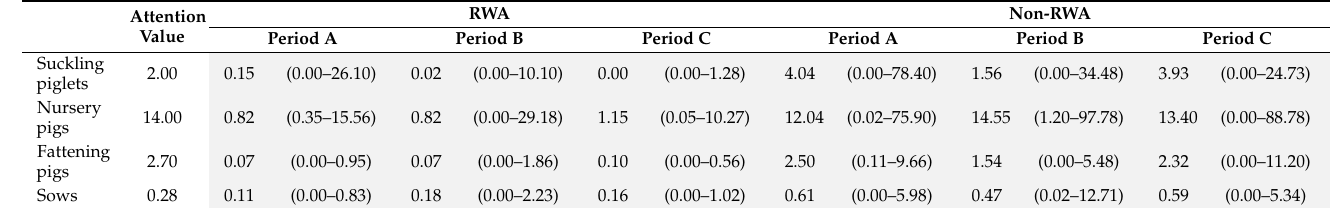
Table 5. The median (min.–max.) BD100 of the farms for the different animal categories for the Raised Without Antibiotics (RWA) and the non-RWA pig farms. AMU was determined for three periods (A: 14 months before the first farm visit; B: between first and third farm visit; C: one year after third farm visit). The distribution of RWA vs. non-RWA farms was 10–18, 13–15, and 12–16, for periods A, B, and C, respectively. To raise pigs according to RWA criteria, the BD100 had to be below the attention value for at least three out of four animal categories.